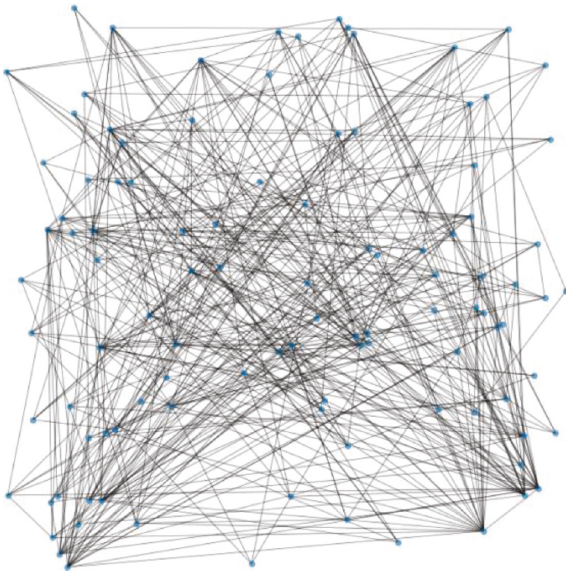
Figure 3: A graph plot of BUP data that created by